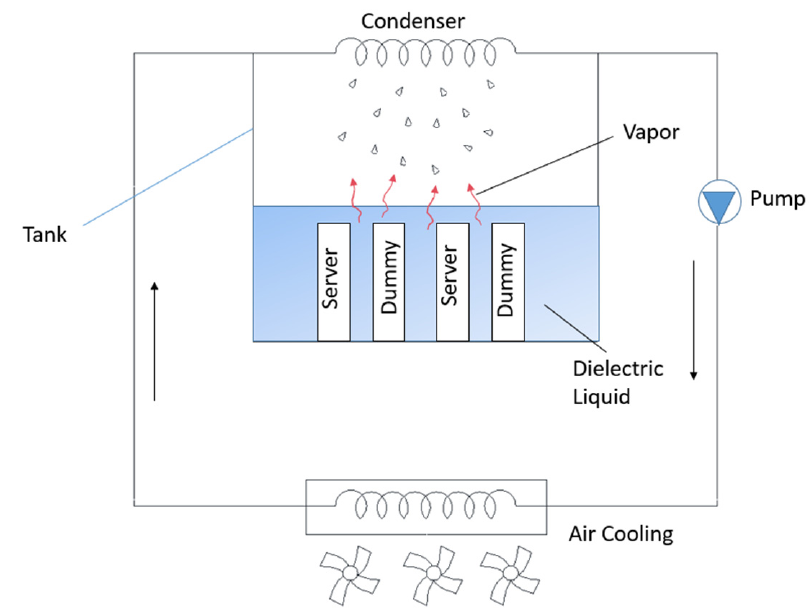
Figure 14. The schematic diagram of two-phase [68].